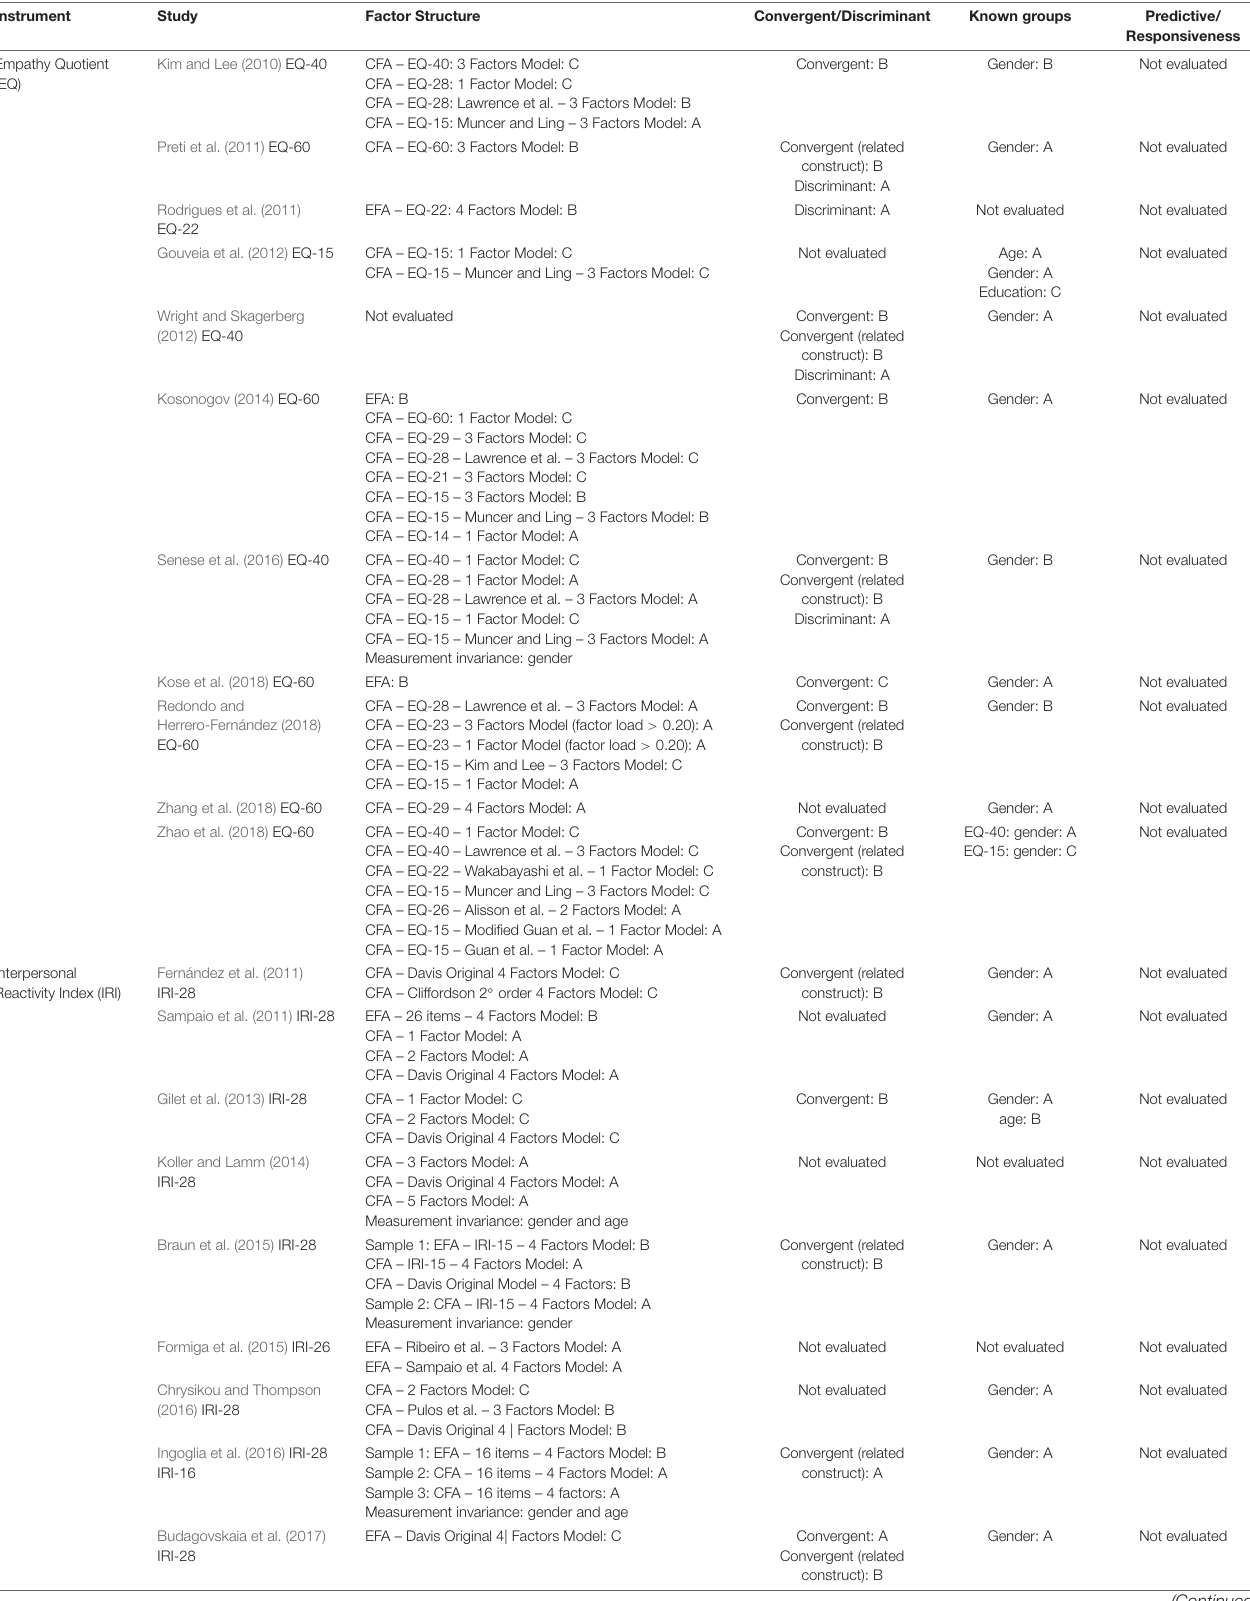
TABLE 4 | Analysis of psychometric qualities by the different instruments according to the studies analyzed ( N = 50) – Part B. Instrument